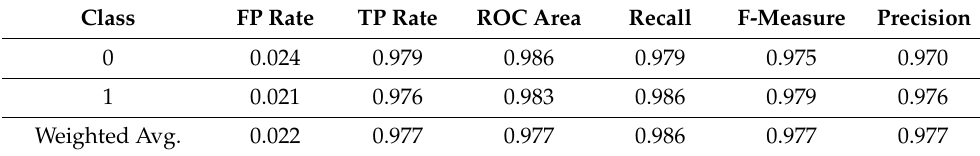
Table 13. Evaluation metrics for J48